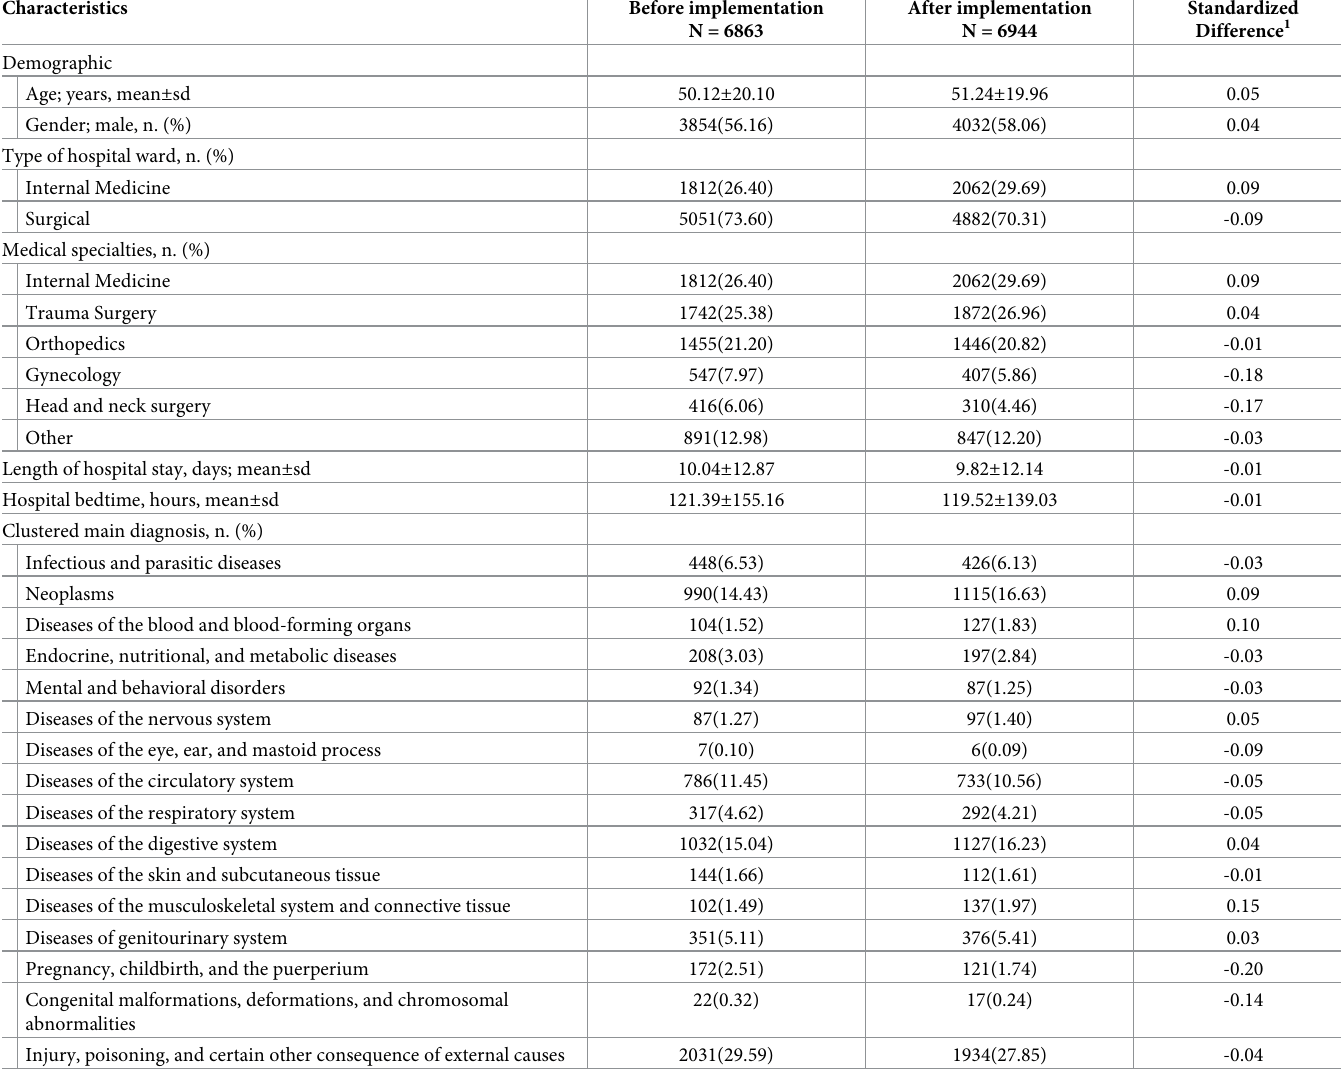
Table 1. Characteristics of the hospitalized patients before and after the implementation of the rapid-response team (RRT) triggered by MEWS � 4 in wards that offer emergency department support.